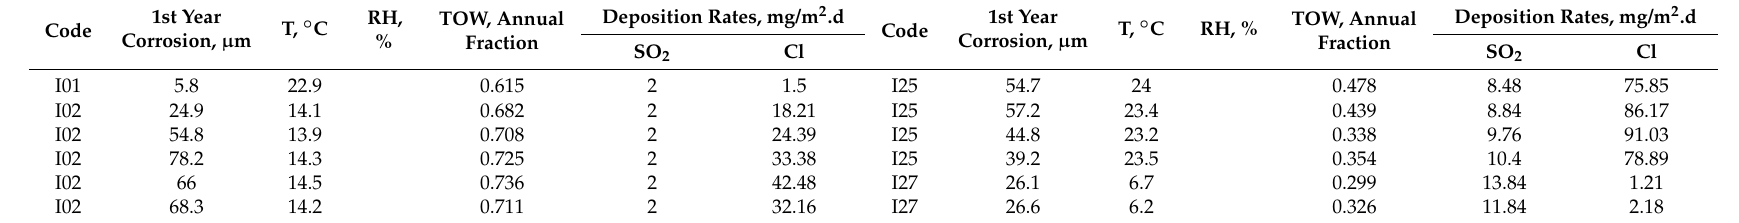
Table 5. ISOCORRAG data considered in the